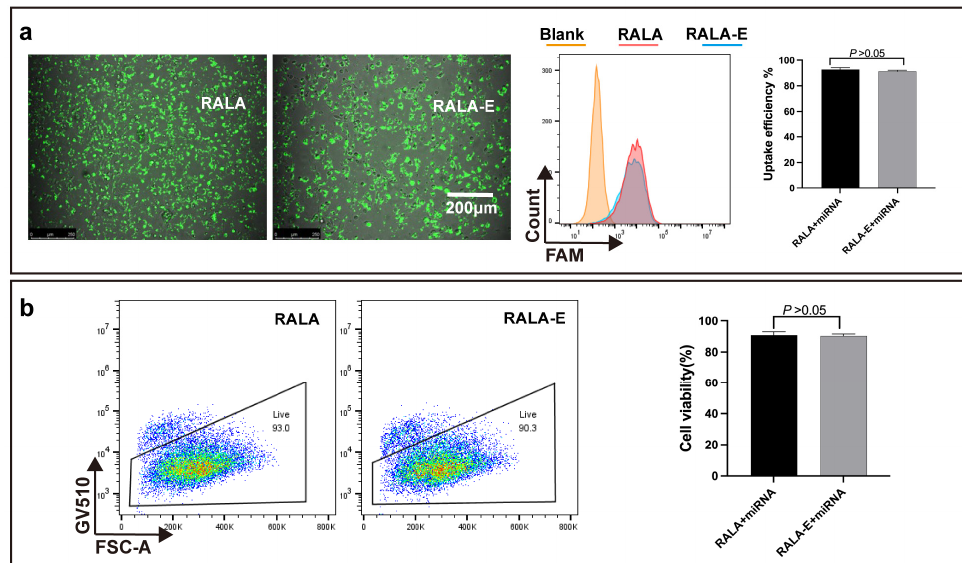
Figure 5. Uptake efficiency and cytocompatibility of RALA-E/miR-146a complex in M1 macrophages. ( a ) Microscope fluorescent image, flow cytometry histograms and quantitative results of M1 macrophages 6 h post transfection with RALA/miR-146a and RALA-E/miR-146a complexes at N:P ratio of 9; ( b ) The proportion of live cells and quantitative results 24 h post-transfection by RALA/miR-146a and RALA-E/miR-146a complexes.